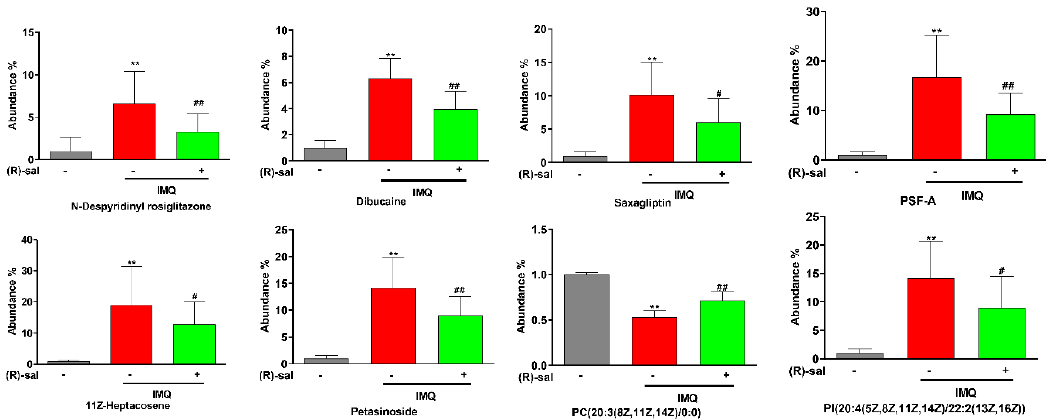
Figure 8. Abundant of some metabolites in plasma of mice from control, IMQ and ( R )-salbutamol groups. # p < 0.05, ## p < 0.01, relative to IMQ group. ** p < 0.01, relative to the control group.